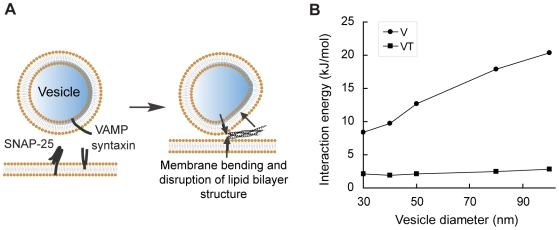
Estimate of membrane bending induced by electrostatics of SNARE complex.(A) Schematic diagram illustrating that free energy released in SNARE complex assembly is transmitted to the transmembrane domains and forces the closing of two fusing membranes (pair of vertical black arrows); meanwhile, strong electrostatic repulsion between SNARE and the v-membrane pushes the membrane away from the center of fusion (tilted black arrow). The resulting force couple should in principle promote bending of the v-membrane. Since SNARE/t-membrane electrostatic interactions are weak, no strong bending is expected on the t-membrane. (B) A standard curve for estimating the degree of bending induced by the electrostatics of SNARE. Interaction free energies between SNARE and a series of v-membranes that bear different spontaneous curvatures (i.e. local radii) were calculated.